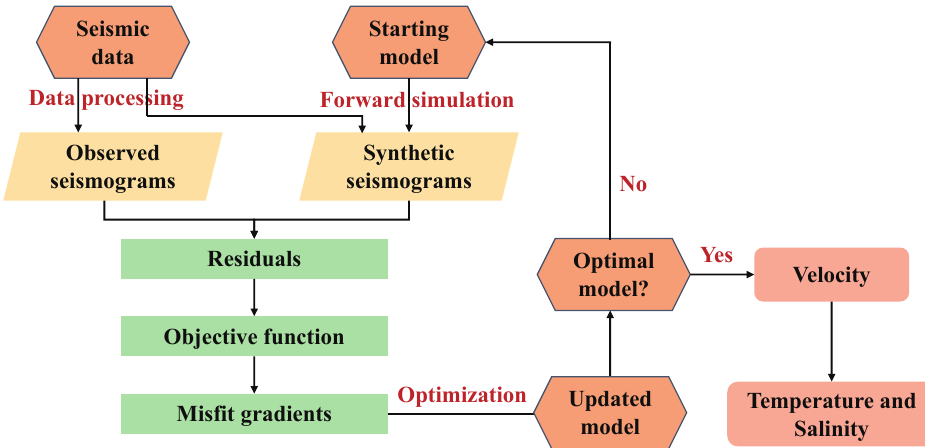
Figure 8. The workflow of FWI, reprinted with permission from Refs. [64,73]. Copyright (2022), with permission from Wiley and